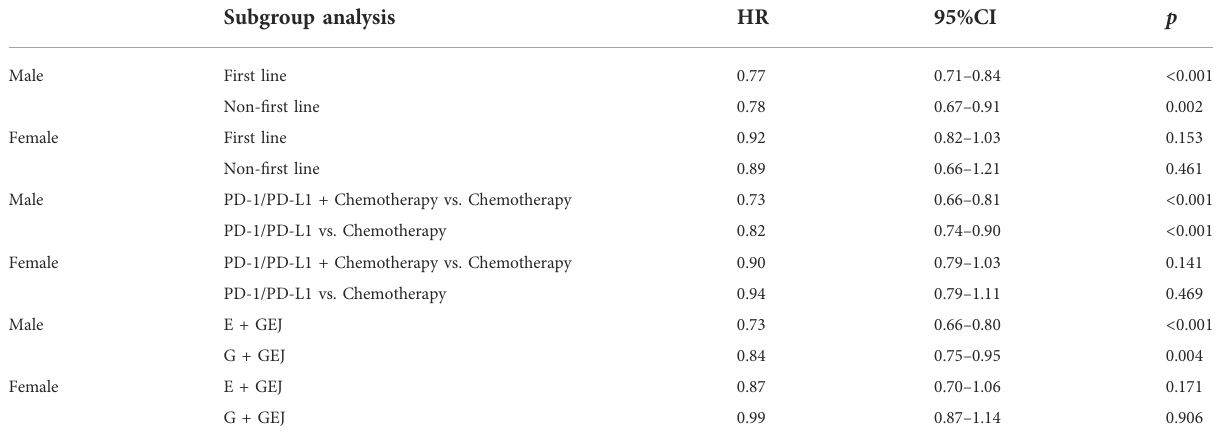
TABLE 5 Subgroup analysis of overall survival in